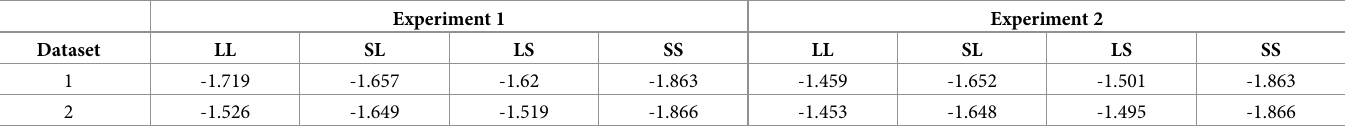
Table 3. Average ELBOs for Experiment 1 and 2. Higher ELBOs stand for more probable